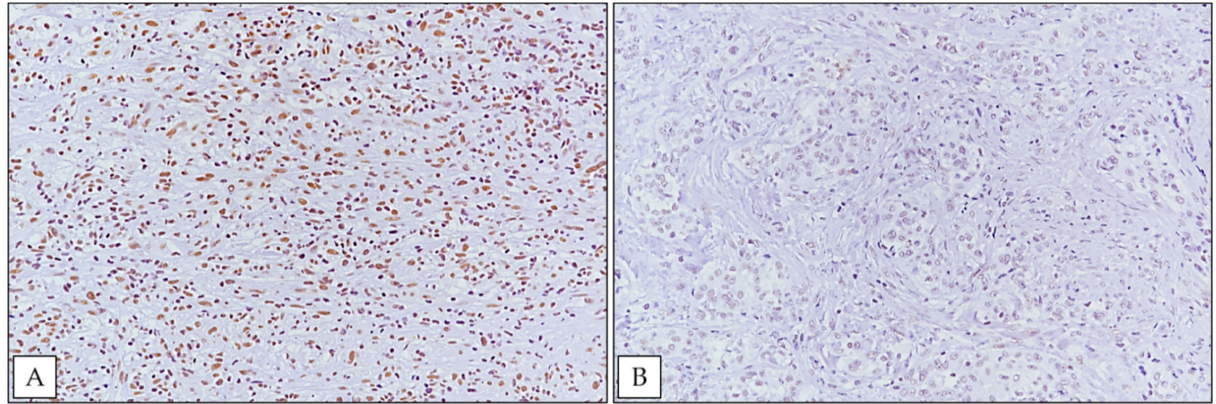
Figure 2. ( A ) Strong nuclear immunohistochemical expression of SRSF1 in a case of biphasic MPM (immunoperoxidase staining; original magnification 200 × ); ( B ) weak SRSF1 immunoexpression in an epithelioid MPM case from our cohort (immunoperoxidase staining; original magnification 200 ×